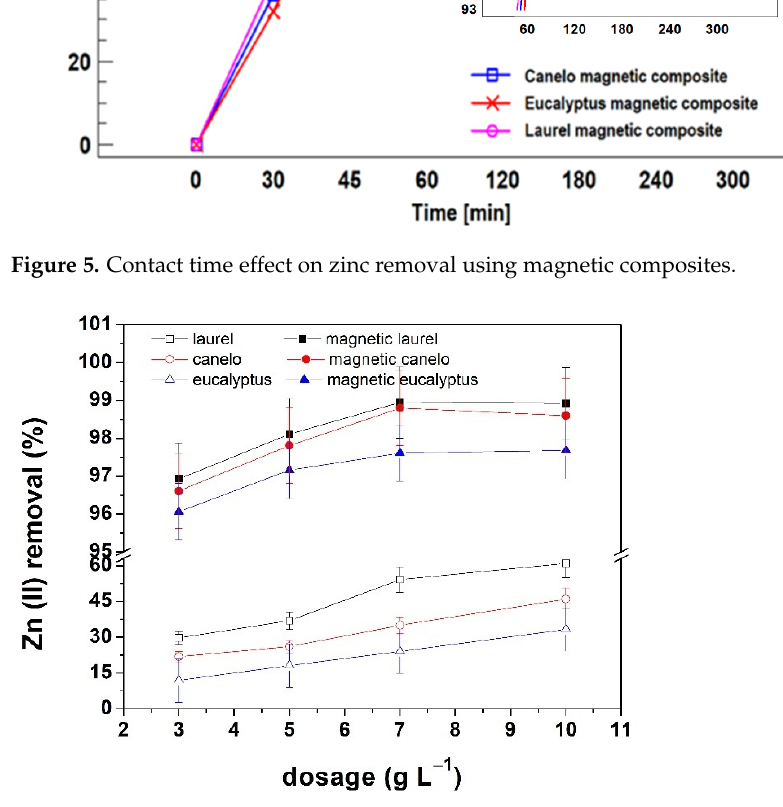
Figure 6. Effect of adsorbent dosage on zinc removal using lignocellulosic biomass before and after magnetite impregnation. magnetite